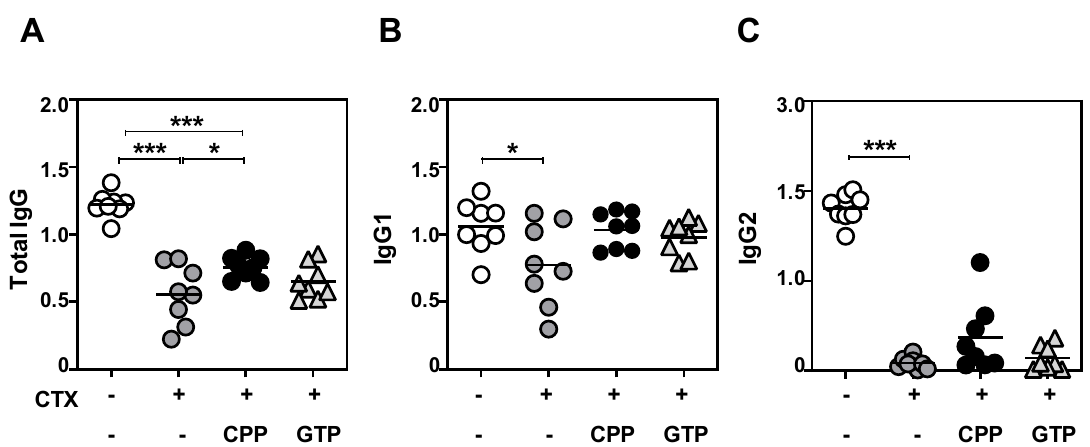
Figure 4. CPP treatment enhanced the antibody response to an influenza virus challenge. Influenza serum antibody titers were measured by total IgG ( A ), IgG1 ( B ), or IgG2 ( C ) ELISA. Mice were administered cyclophosphamide (CTX) and CPP (300 mg/kg), green tangerine polysaccharide (GTP, 300 mg/kg) as a positive control, or vehicle as a negative control. n = 8. Statistical difference by one-way ANOVA with Tukey’s post hoc test. * p < 0.05, ** p < 0.01, *** p < 0.001 .